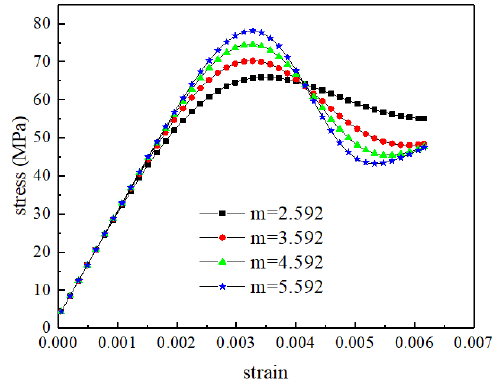
Fig. 6 The influence of the parameter m on the constitutive model.